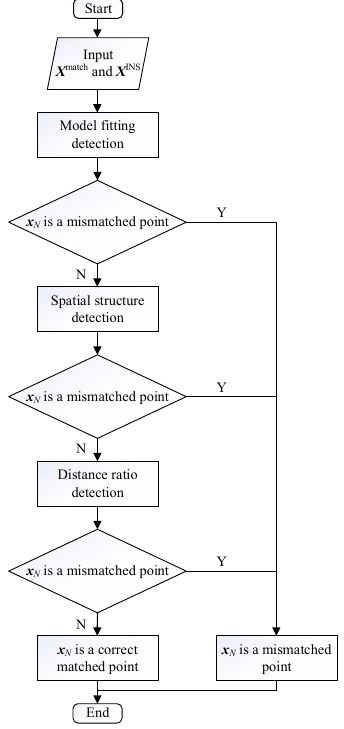
Figure 1. The flow of the proposed mismatch detection method.